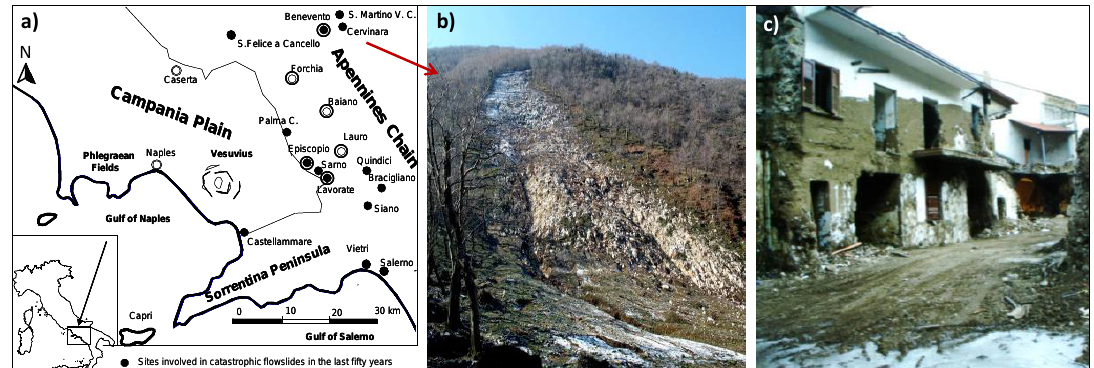
Figure 1. ( a ) Location of Cervinara and other sites subjected to flow-like landslides; ( b ) the Cervinara flowslide; ( c ) some effects of the landslide in the town.